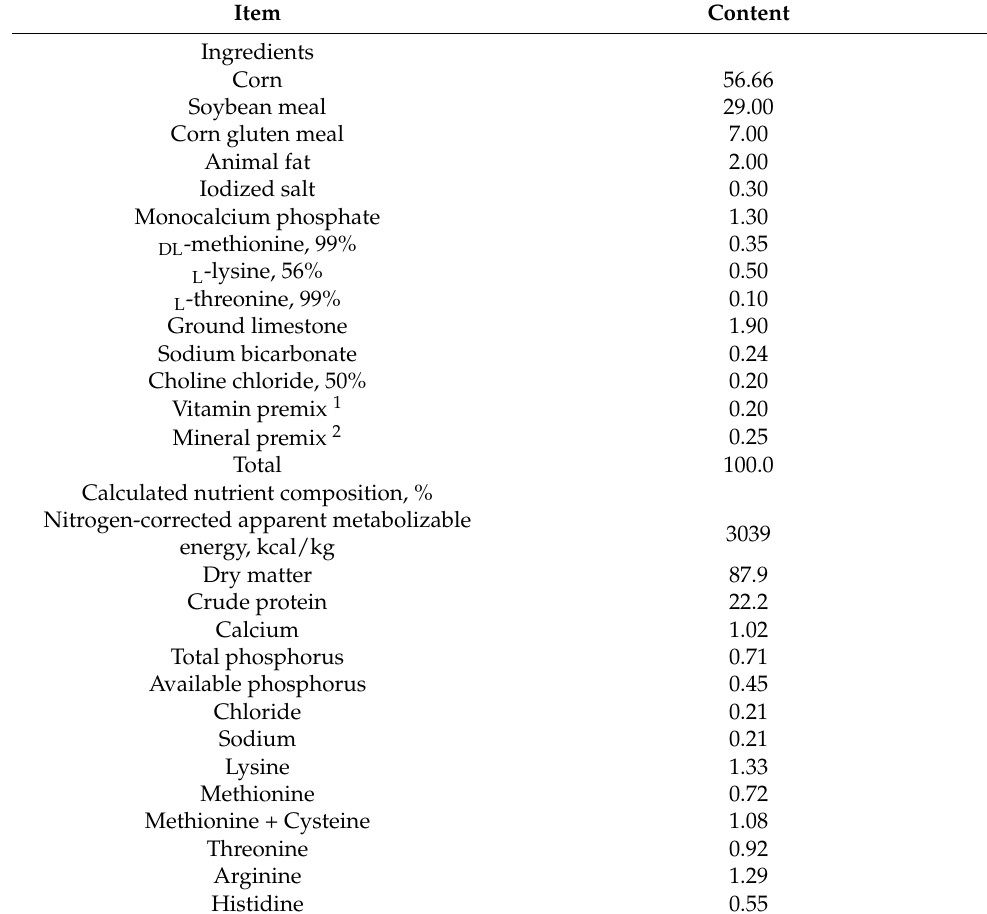
Table 1. Ingredients in and chemical composition of the basal diet (%, as-fed